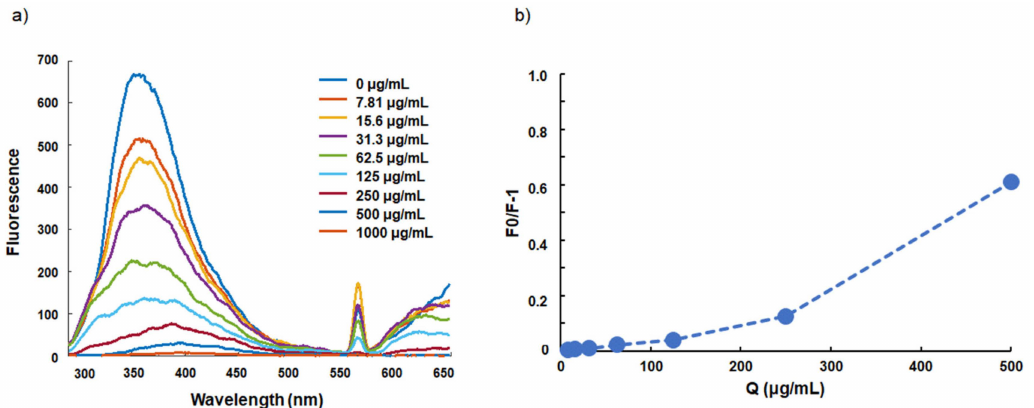
Figure 1. Emission spectra of bovine serum albumin (BSA) in the presence of di ff erent concentrations of Flavan-3-ols (FLs) ( a ), and Stern–Volmer plot ( b ), where F and F 0 are the emission intensities in the presence and absence of FLs, respectively, measured at the emission wavelength of 350